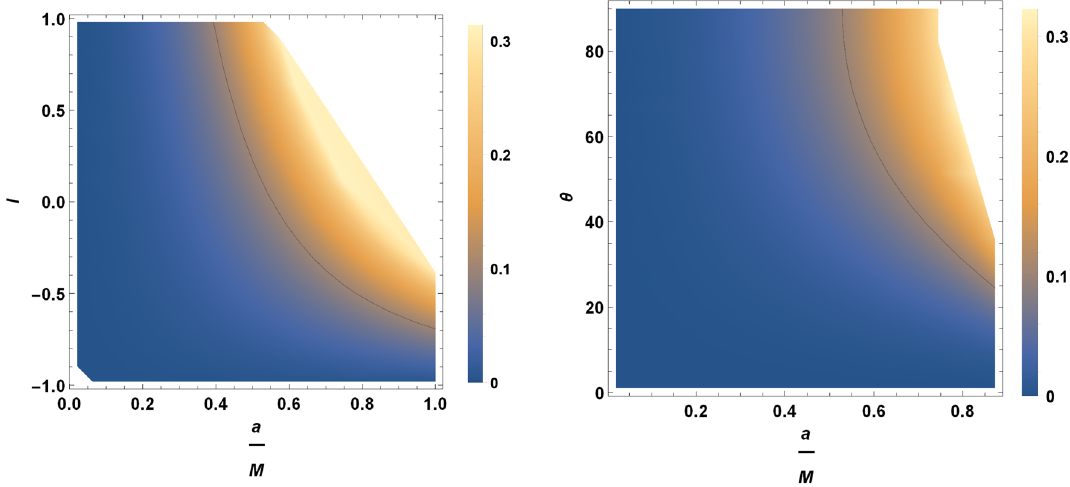
Fig. 19 The observable for deviation from circularity (cid:2) C as a function of black hole parameters. The left one is for b = 0 . 1 and k = 0 . 1. The right one is for l = 0 . 1, b = 0 . 1, and k = 0 . 1. Here the angle of inclination is θ = 90 ◦ . The black lines in the figures correspond to (cid:2) C = 0 .